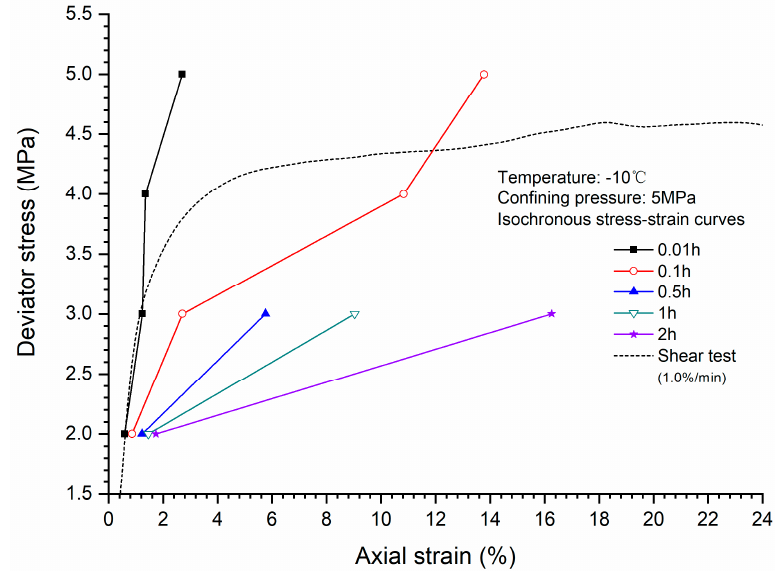
Figure 16. The isochronous stress-strain curves for methane hydrate-bearing frozen specimens under high deviator stresses.